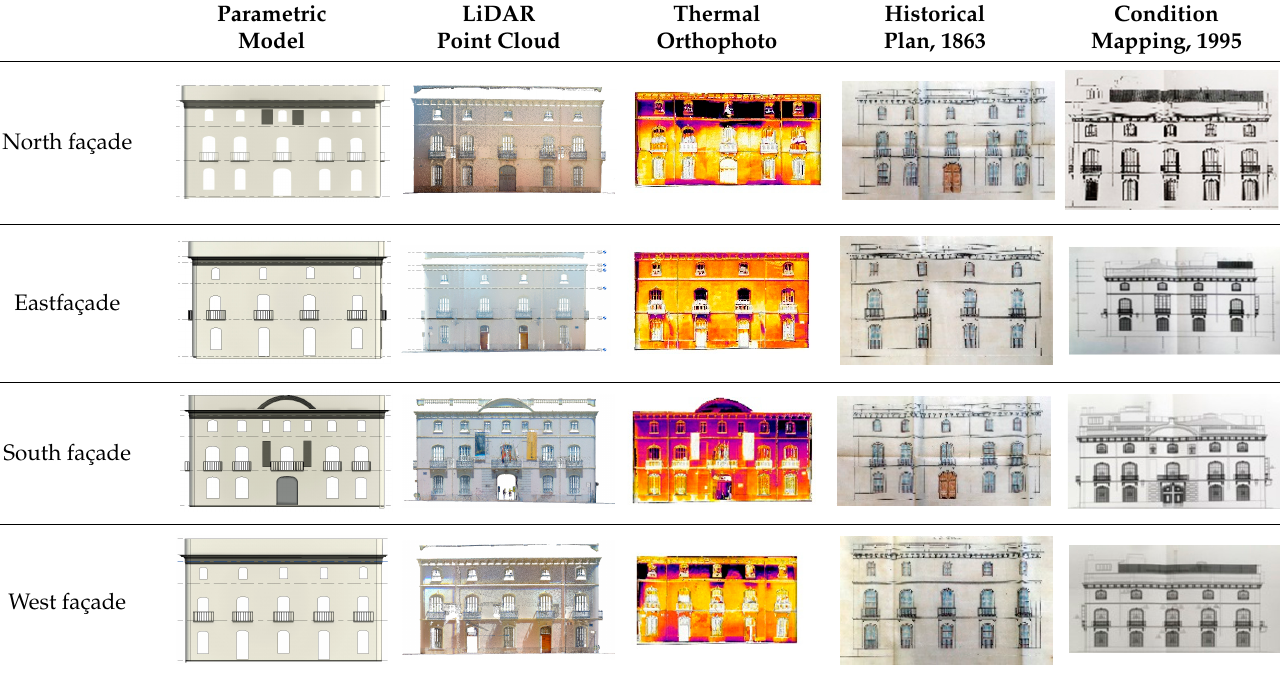
Table 2. Overview of the Palacio de Colomina façades considering the parametric model, the primary data used during the modelling phases (e.g., LiDAR point clouds and thermal orthoimagery), and the historical sources.